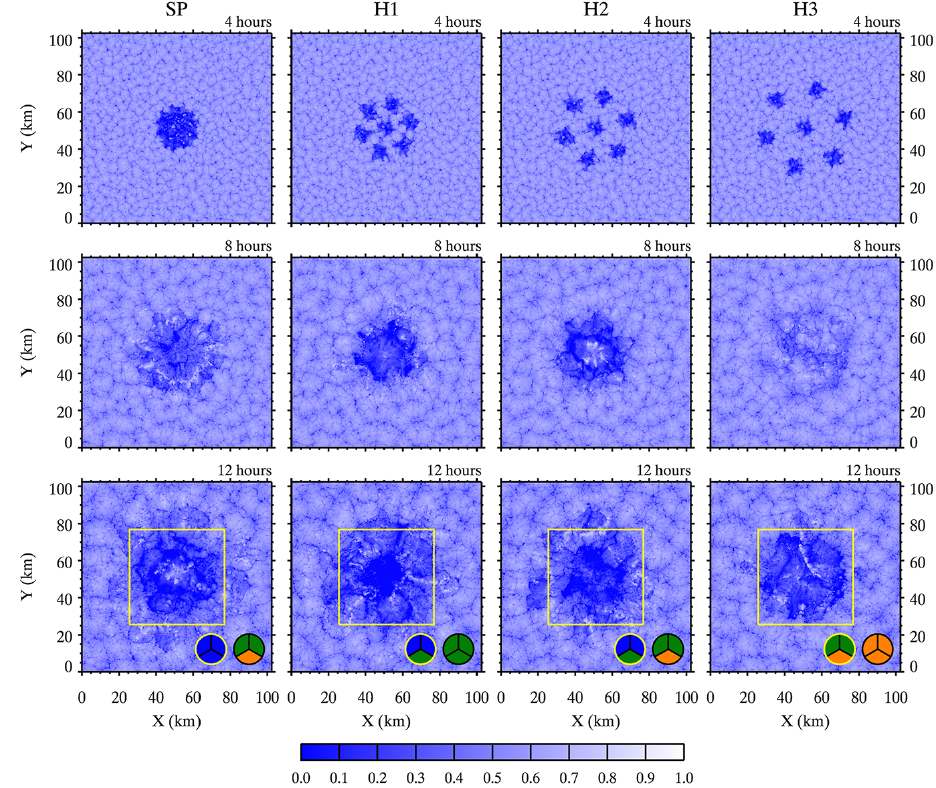
Figure 9. Time evolution of the computed albedo for S3 simulations. For the albedo at 12h, the metric calculations for the open-cell transition are applied to two squares: 51.2km width (yellow) and the entire domain (102.4km width). The same colors are used for the square and the circumference of the schematic metric circles.